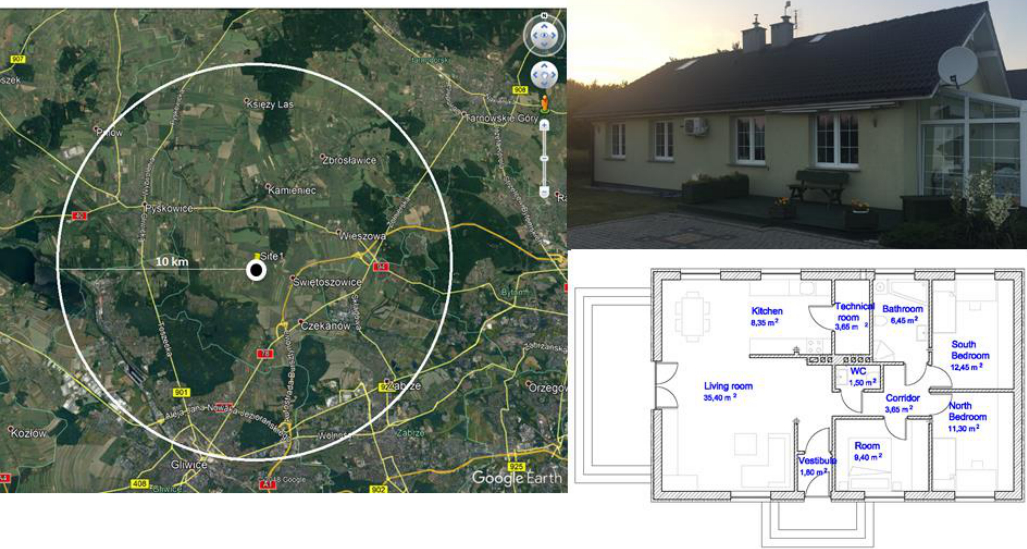
Figure 1. Location, south view and ground floor plan of the house.